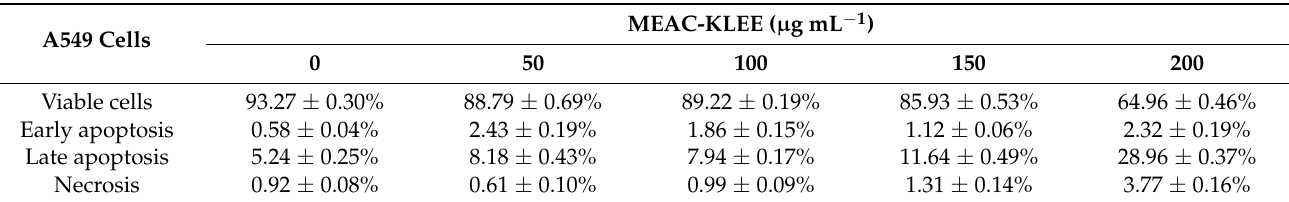
Table 3. Cytotoxicity of MEAC-KLEE against A549